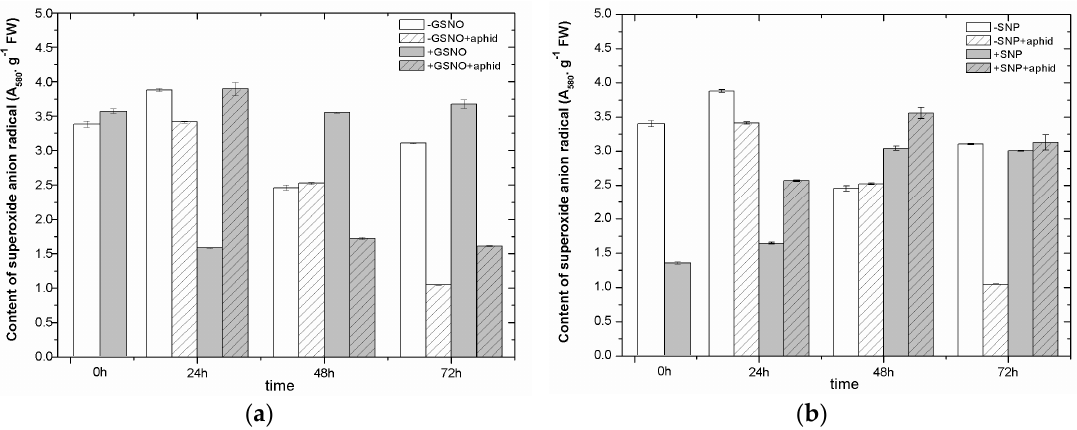
Figure 3. The effect of nitric oxide donors (GSNO ( a ); and SNP, ( b )) and A. pisum on the generation of the superoxide anion in leaves of P. satium L. cv. Cysterski. The data were obtained in three independent experiments and statistically analysed using ANOVA ( p -values at α = 0.05). Hypotheses on the equality of means were verified by the two-sample t -test (Table S2). To account for multiple testing, we used the Bonferroni correction.